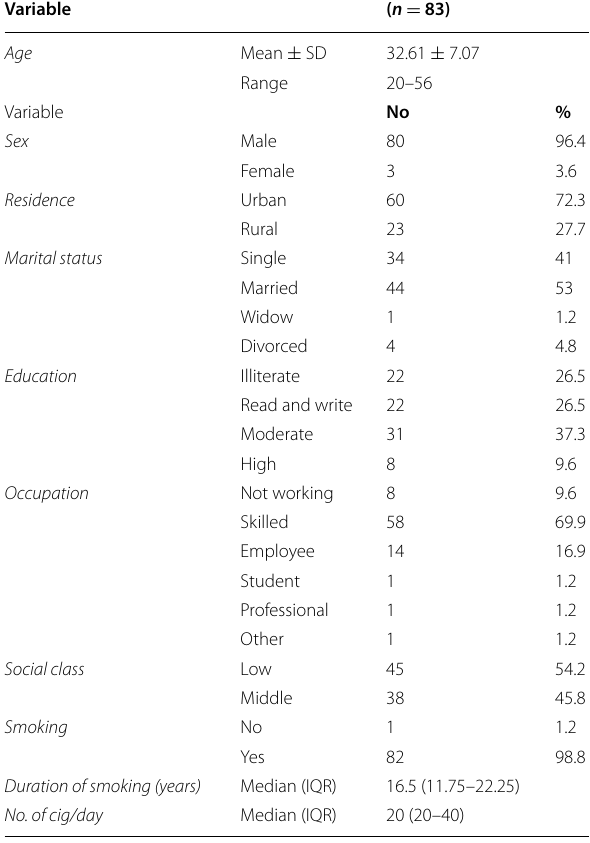
Table 1 Demographic characteristics of the studied group